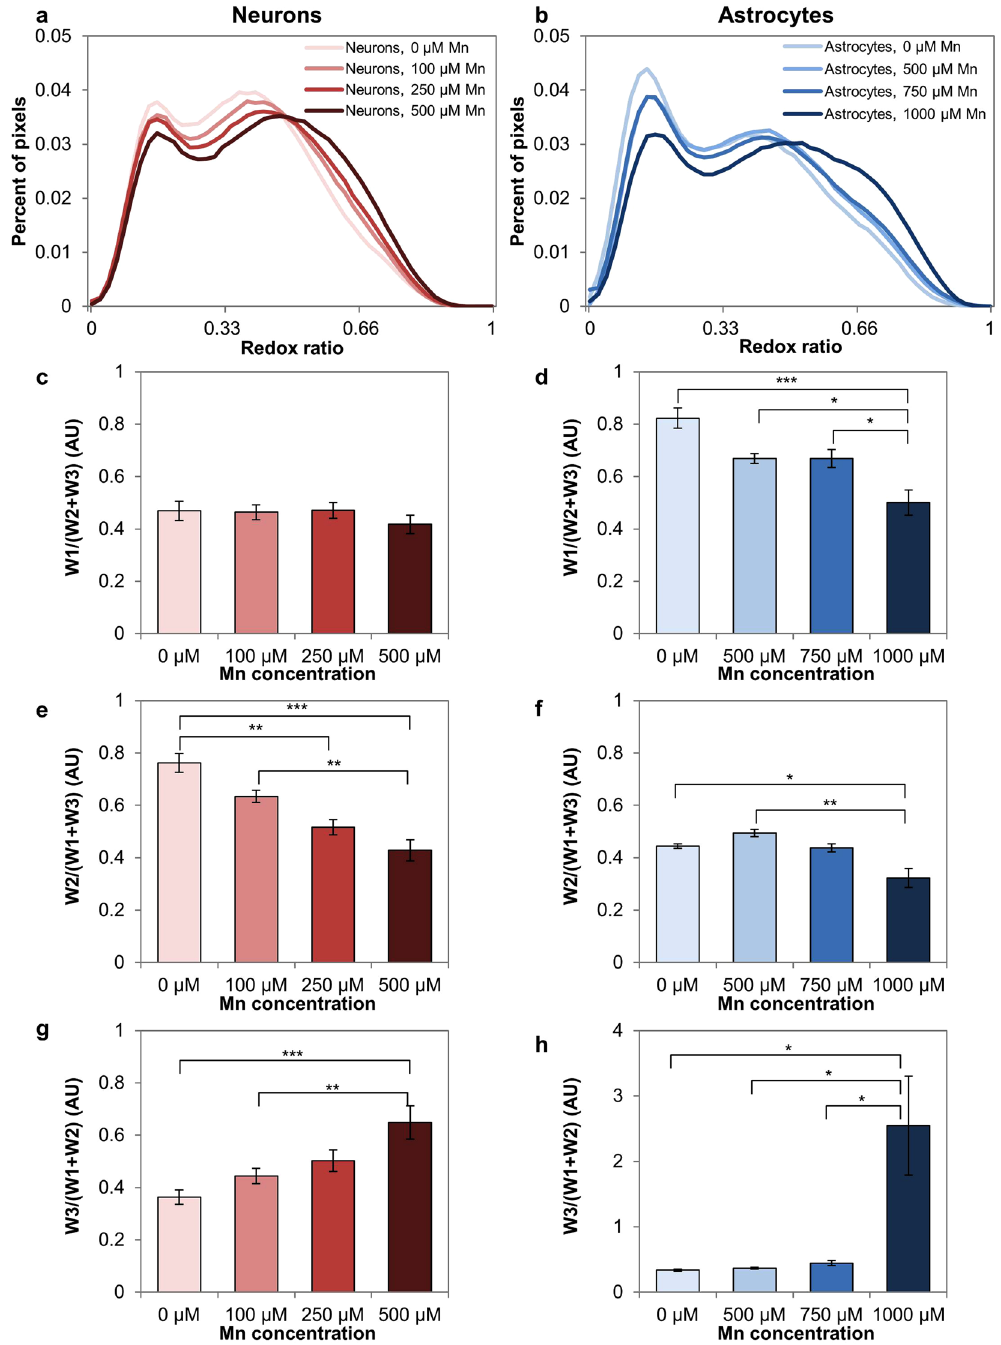
Figure 6. Quantitative comparisons of redox ratio distributions in response to Mn treatment. ( a , b ) Redox ratio distributions for neurons ( a ) and astrocytes ( b ) show a broadening in high redox ratio values with increasing Mn dose. ( c ) Relative weight of redox ratio component 1 is consistent in neurons across Mn doses. ( d ) Relative weight of redox ratio component 1 declines with dose in astrocytes. ( e ) Relative weight of redox ratio component 2 declines in neurons across Mn doses. ( f ) Relative weight of redox ratio component 2 declines with dose in astrocytes. ( g ) Relative weight of redox component 3 increases in neurons with dose. ( h ) Relative weight of redox ratio component 3 increases with dose in astrocytes. * p < 0.05, ** p < 0.01, *** p <